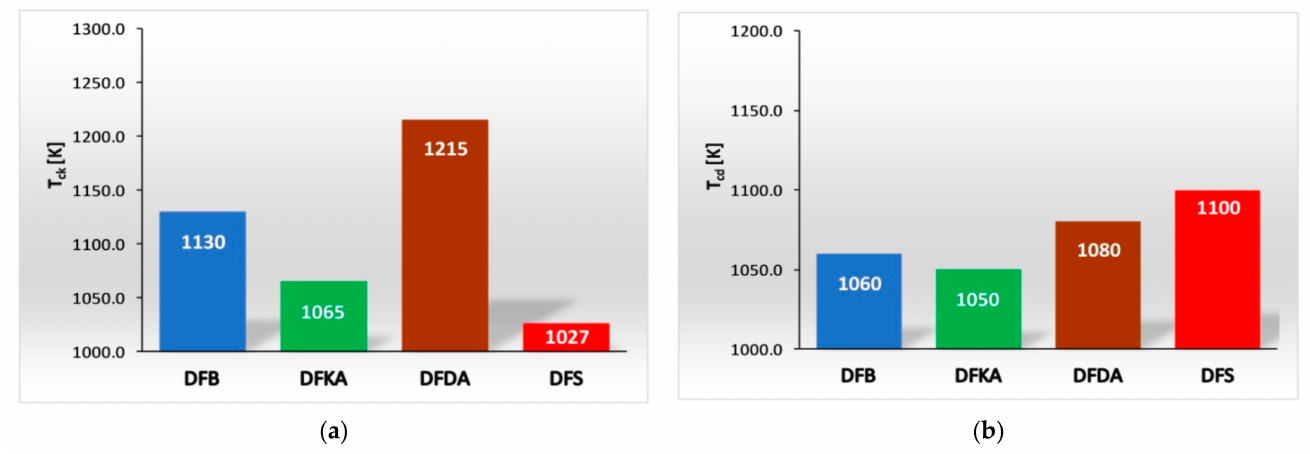
Figure 17. ( a ). Combustion temperature (T ck ) in kinetic combustion phase for tested fuels. ( b ) Com- bustion temperature (T cd ) in diffusion combustion phase for tested